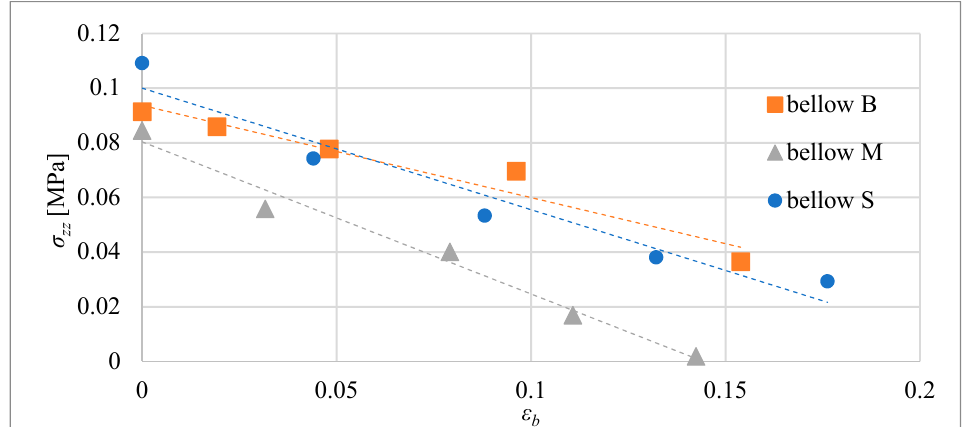
Figure 19. Blocking stress of actuators as a function of relative elongation for a temperature of 75 °C.